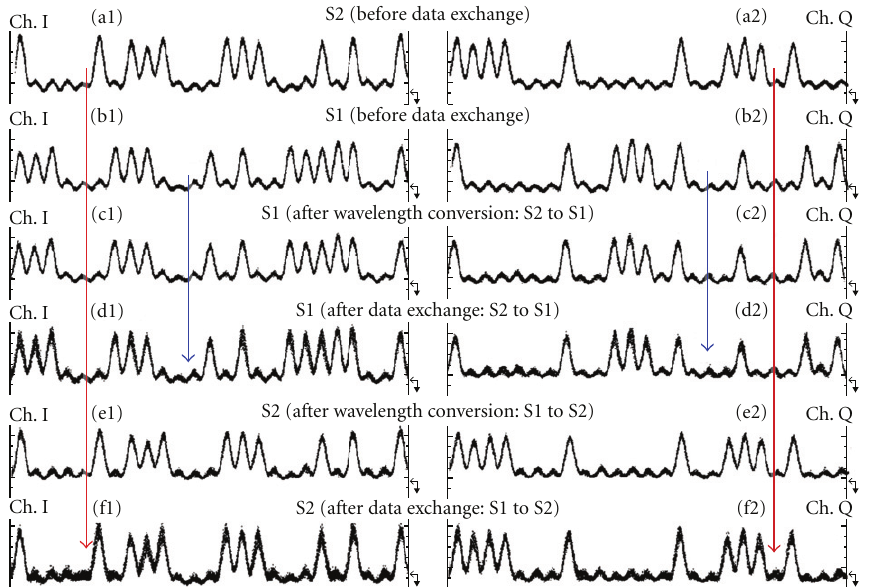
Figure 15: Demodulated waveforms (Ch. I and Ch. Q) for 100 Gbit/s DQPSK data exchange. (a1 and a2) S1 before exchange (P1: OFF, P2: OFF). (b1 and b2) S2 before exchange (P1: OFF, P2: OFF). (c1 and c2) S1 after wavelength conversion (WC: S2 to S1) (S1: OFF, S2: ON, P1: ON, P2: ON). (d1 and d2) S1 after exchange (Ex.: S2 to S1) (S1: ON, S2: ON, P1: ON, P2: ON). (e1 and e2) S2 after wavelength conversion (WC: S1 to S2) (S1: ON, S2: OFF, P1: ON, P2: ON). (f1 and f2) S2 after exchange (Ex.: S1 to S2) (S1: ON, S2: ON, P1: ON, P2: ON). (a1)–(f1)